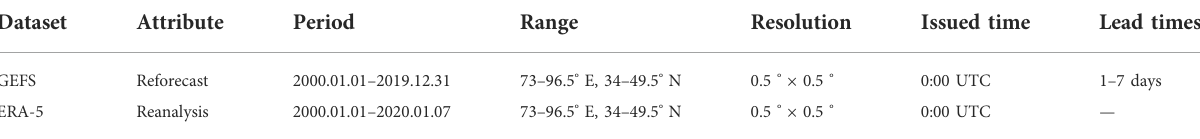
TABLE 1 Descriptions of forecast and observation datasets.